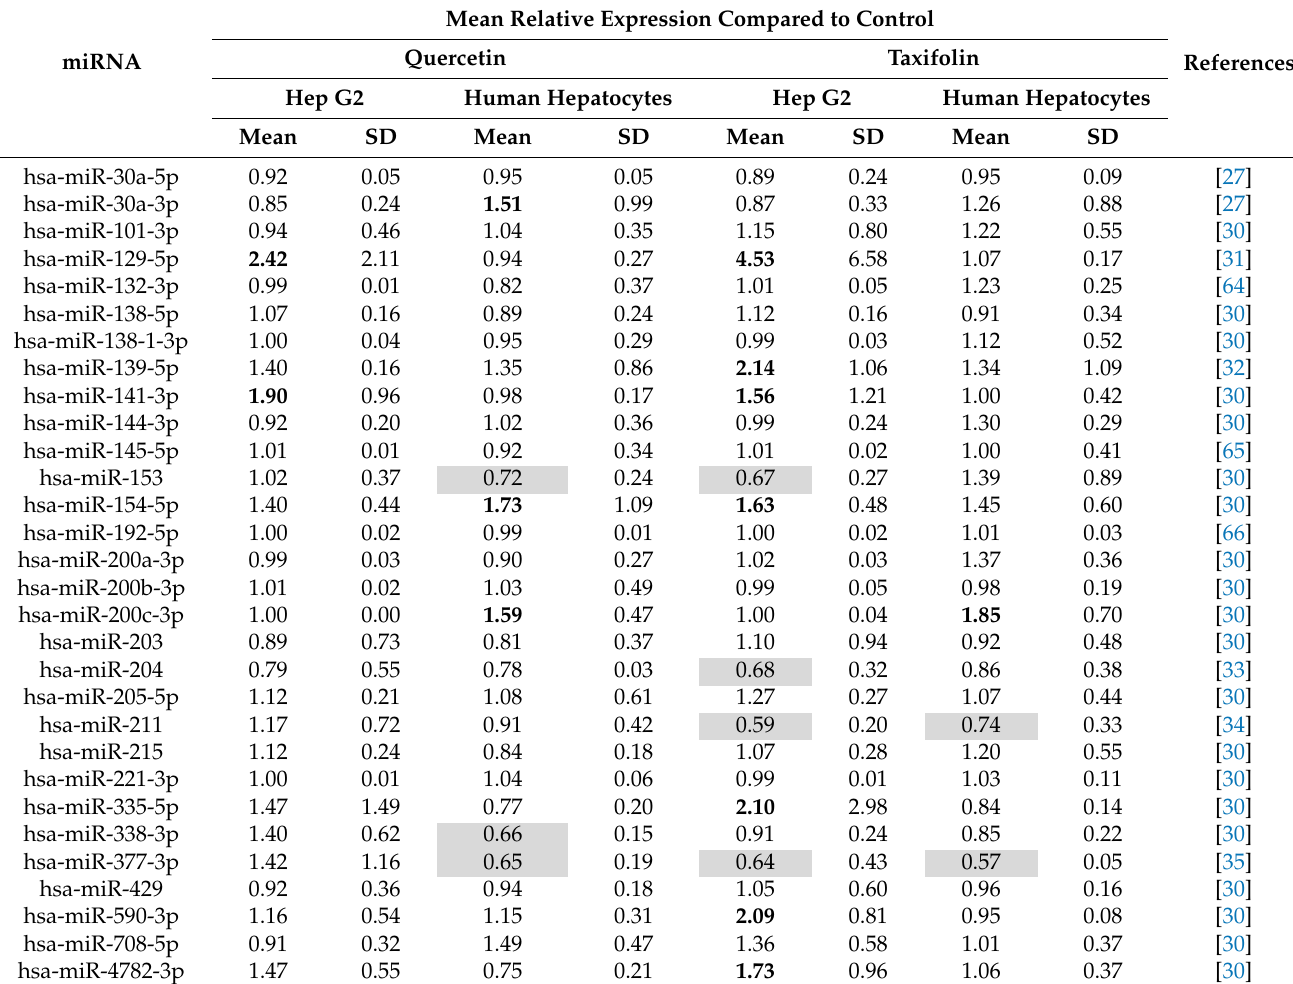
Table A1. Expression analysis of miRNAs that contain ZEB2 as their validated target in Hep G2 and human hepatocytes. Mean Relative Expression Compared to miRNA